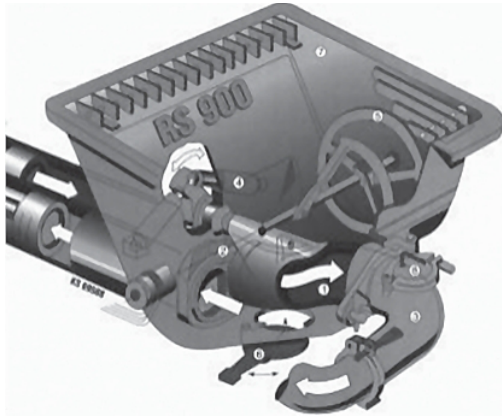
Fig. 1. Piston concrete mixture pump with S type valve produced by “Putzmeister”